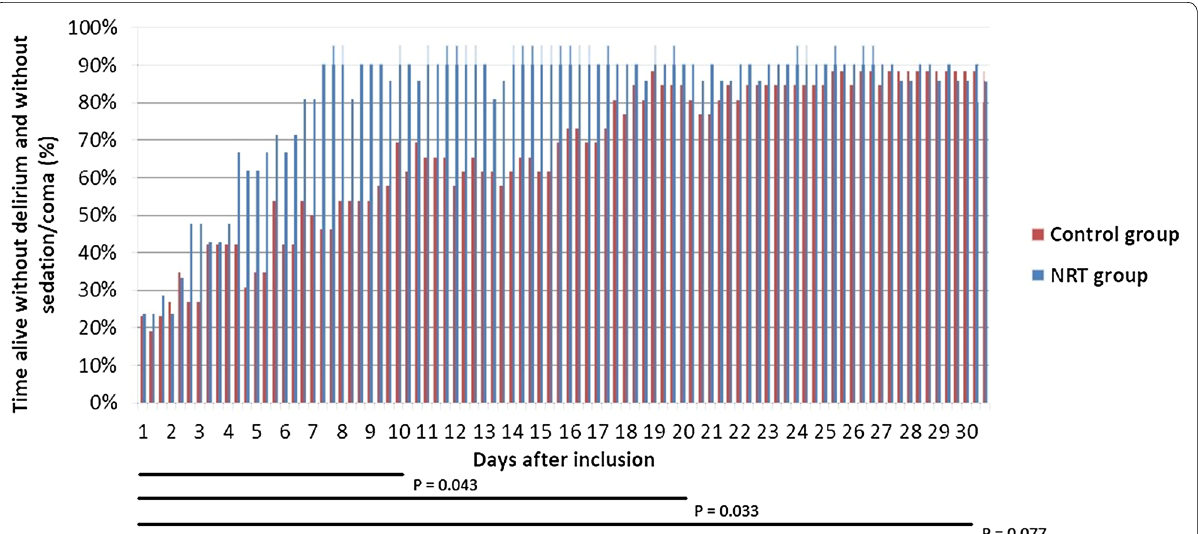
Fig. 3 Patients alive without delirium and without sedation or coma comparing nicotine replacement therapy and placebo group. Data presented as the percentage of time patients were alive without delirium and without sedation or coma (RASS